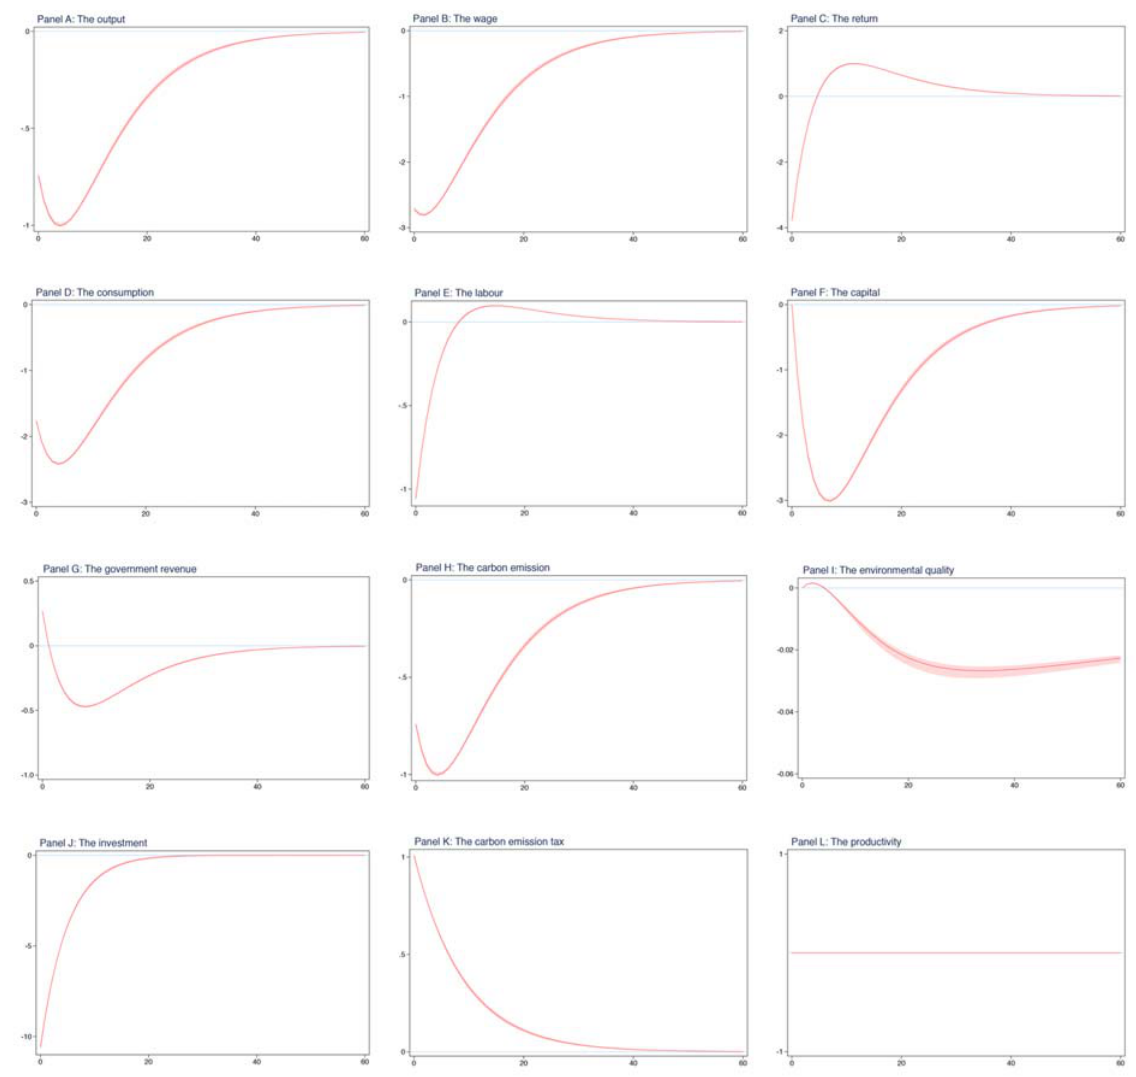
Figure 4. The impulse responses from Bayesian estimation.